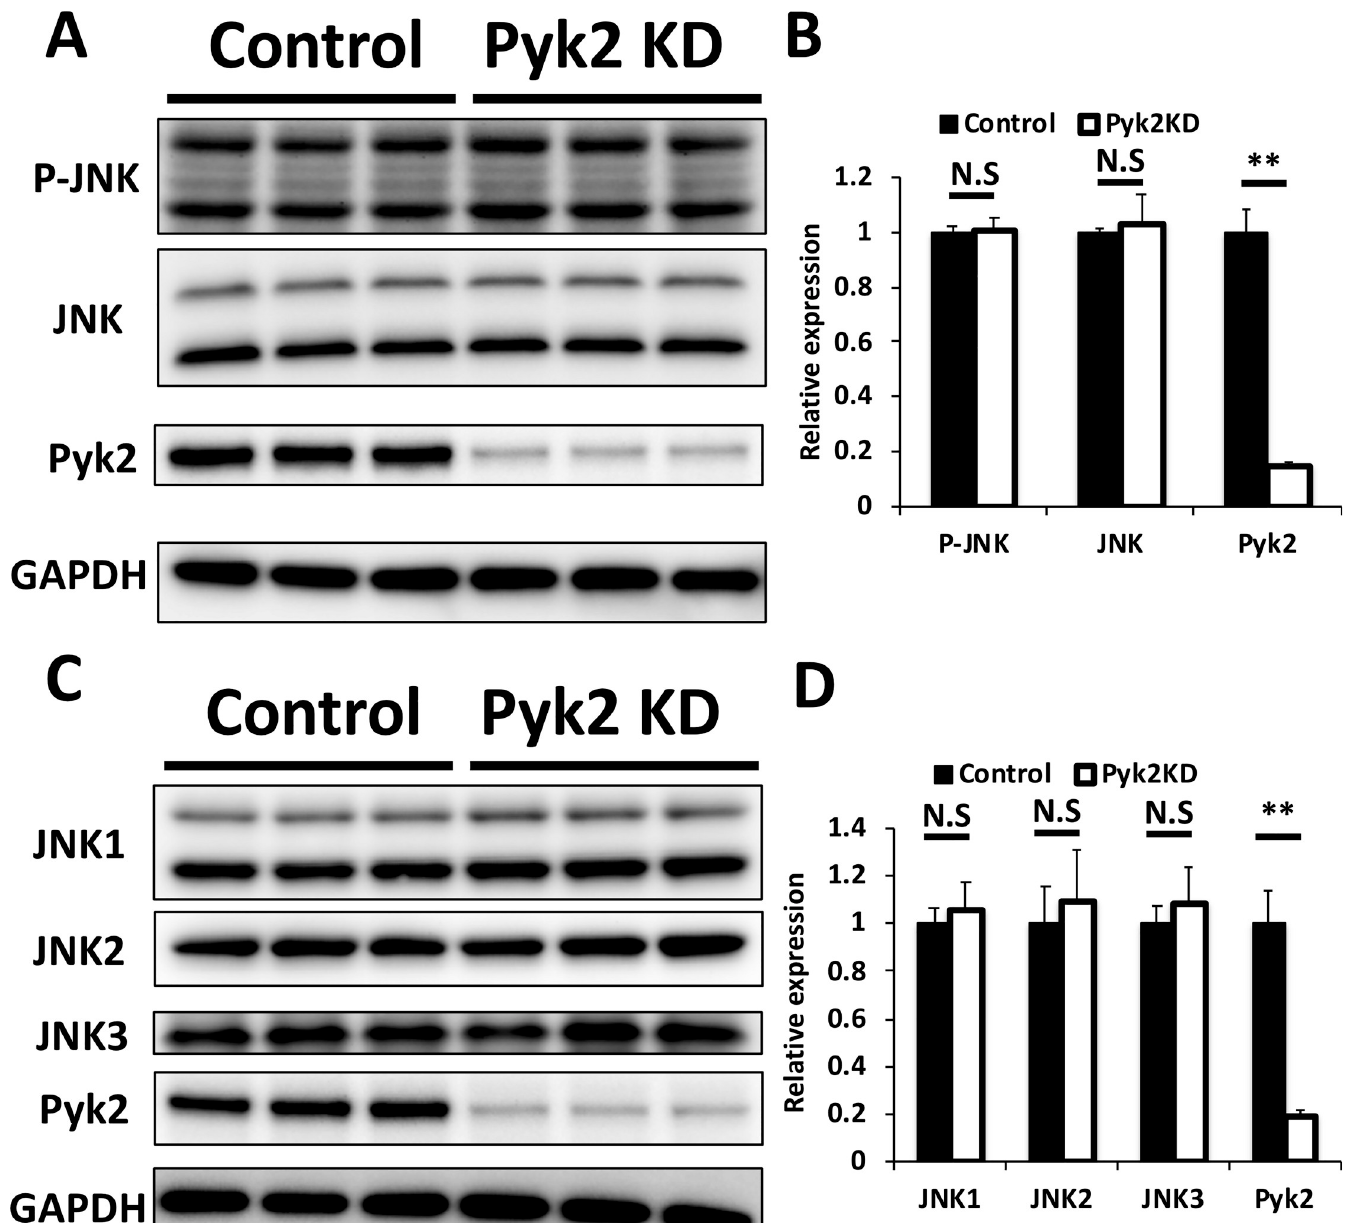
Fig 7. Effect of Pyk2 knockdown on JNK activation and expression. (A) EpH4-Cl3 cells were transfected with scrambled siRNA (Control) or siRNAs targeted to mRNAs encoding Pyk2 (Pyk2 KD). After 48 h, extracts from control cells or Pyk2-knockdown EpH4-Cl3 cells were subjected to immunoblotting using antibodies against phosphorylated (active) JNK (Thr-183/Tyr-185) (P-JNK), JNK, Pyk2, and GAPDH. (B) Band intensities of P-JNK, JNK, and Pyk2 in (A) were measured and normalized to GAPDH expression. The expression levels in control cells were set to 1. The means and SEMs are shown in the graph ( n = 3; �� p < 0.01; N.S. p > 0.05). (C) EpH4-Cl3 cell extracts were prepared after the cells were treated, as described in (A), and subjected to immunoblotting using antibodies against JNK1, JNK2, JNK3, Pyk2, and GAPDH. (D) Band intensities of JNK1, JNK2, JNK3, and Pyk2 in (C) were measured and normalized to GAPDH expression. The expression levels in control cells were set to 1. The means and SEMs are shown in the graph ( n = 3; �� p < 0.01; N.S. p >